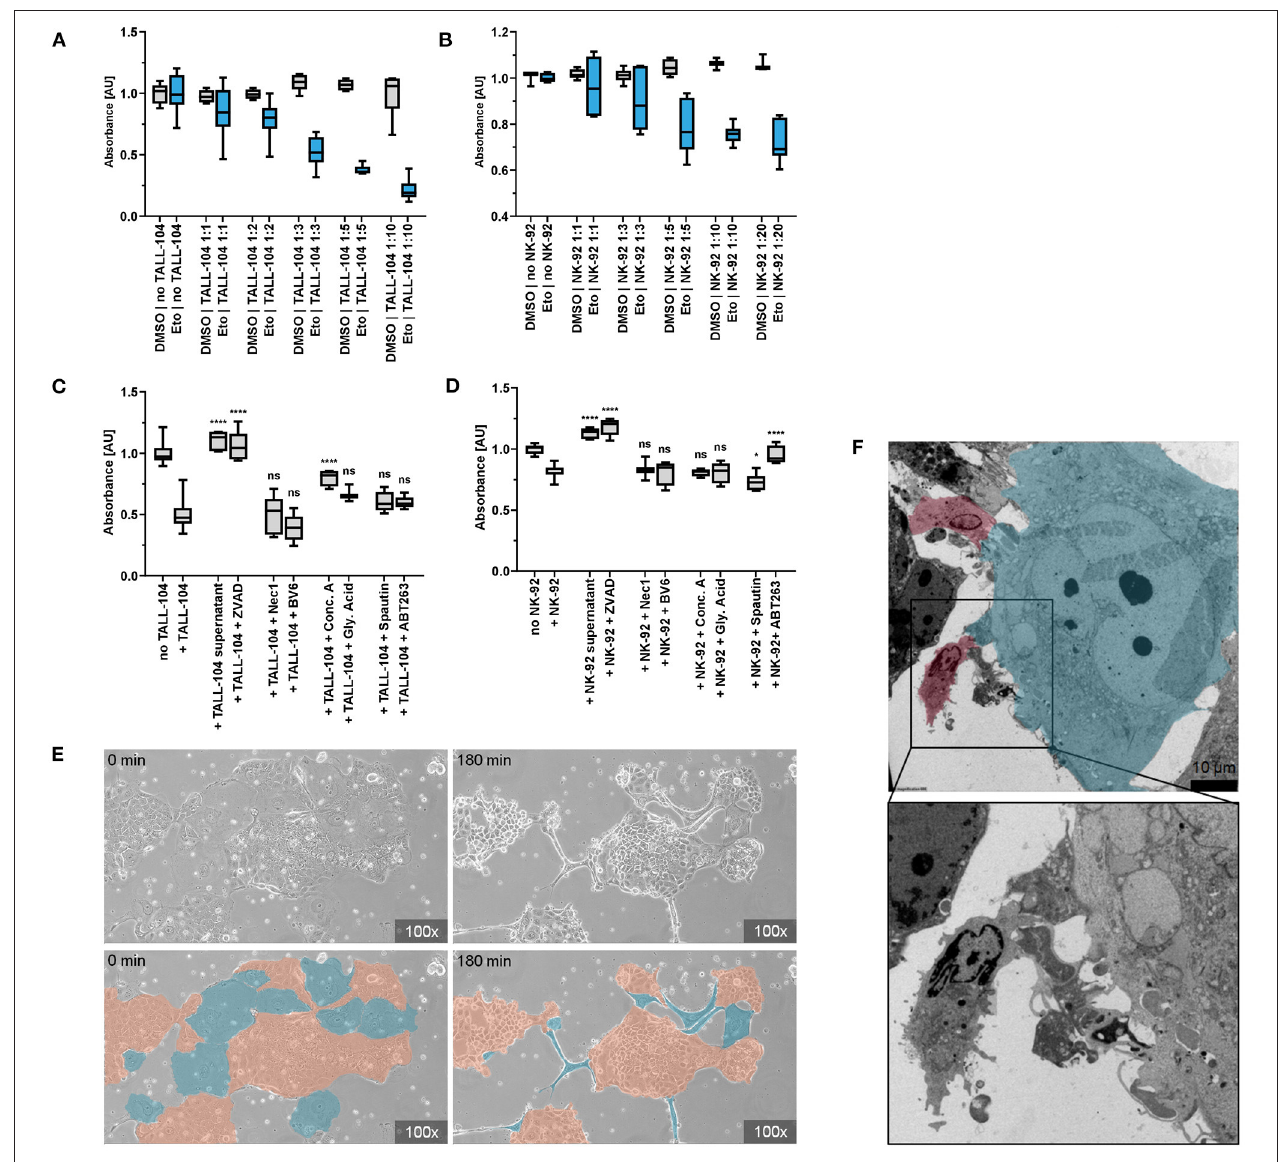
FIGURE 4 | Co-incubation of senescent cells and immune cells. (A,B) CRV absorbance of remaining adherent cells after co-incubation of senescent Caco-2 cells and immune cells. Co-incubation with TALL-104 (A) or NK-92 (B) immune cells lead to dose-dependent elimination of senescent cells. (C,D) Elimination of senescent cells under the influence of immune cell conditioned supernatant and various inhibitors of cellular clearance mechanisms as measured by CRV absorbance. TALL-104 (C) and NK-92 (D) experiments are shown. * p ≤ 0.05, ** p ≤ 0.01, *** p ≤ 0.001, **** p ≤ 0.0001, ns = not significant. (E) Life cell imaging of co-incubation of senescent cells and immune cells. Specific elimination of senescent cells (blue) by NK-92 cells while proliferating cells (orange) are spared. (F) Electron microscopy. Cell-cell contact of TALL-104 cells (red) and a senescent cell